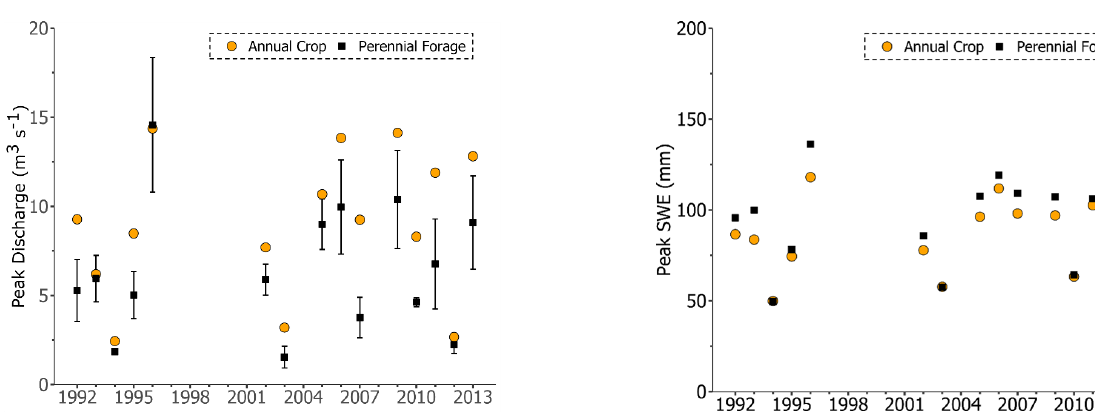
Figure 6. Comparison of peak snow water equivalent (SWE) be- tween annual crop and forage simulations for the La Salle River subbasin (LS-05OG008). Error bars indicate the 95% confidence interval of the forage simulation ensemble. The years 1997–2001, 2004, and 2008 were not used for model assessment due to missing data or equipment